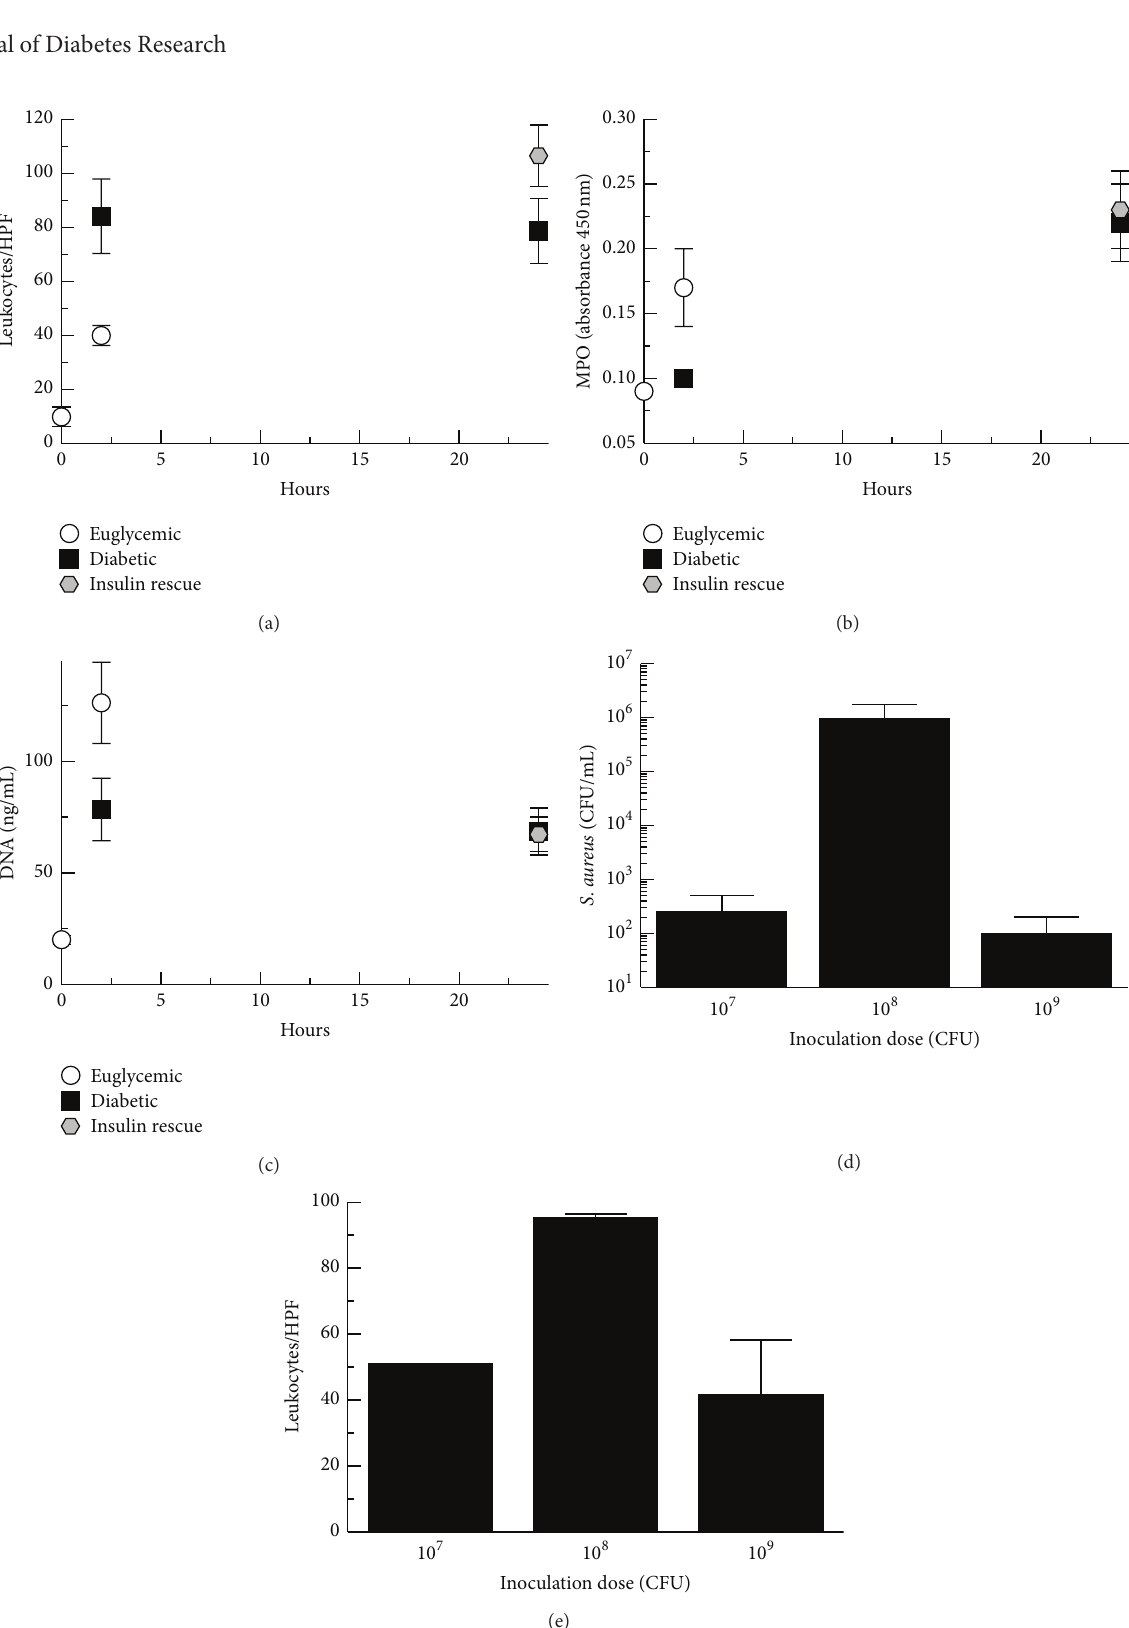
Figure 5: Neutrophil migration into the peritoneum. (a) Leukocytes in the peritoneal fluid wash were quantitated by microscopy of Wright strainedcytospinslides.(b)Myeloperoxidaseactivity(MPO)intheperitonealfluidwashmeasuredusingTMB.(c)FreeDNAintheperitoneal fluid wash measured by spectrophotometry using PicoGreen. Graphed data shows means of results for peritoneal samples from the animals in each treatment group. Error bars denote standard error of the means. S. aureus inoculation dose ranging experiments with peritoneal wash performed at 24 hours after infection. (d) Leukocyte enumeration of peritoneal wash fluid performed by microscopy of Wright-stained cytospin slides. (e) S. aureus recovered from peritoneal wash fluid assayed by colony